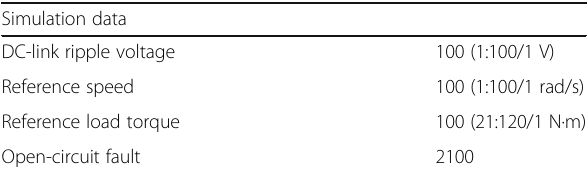
Table 3 Data acquisition